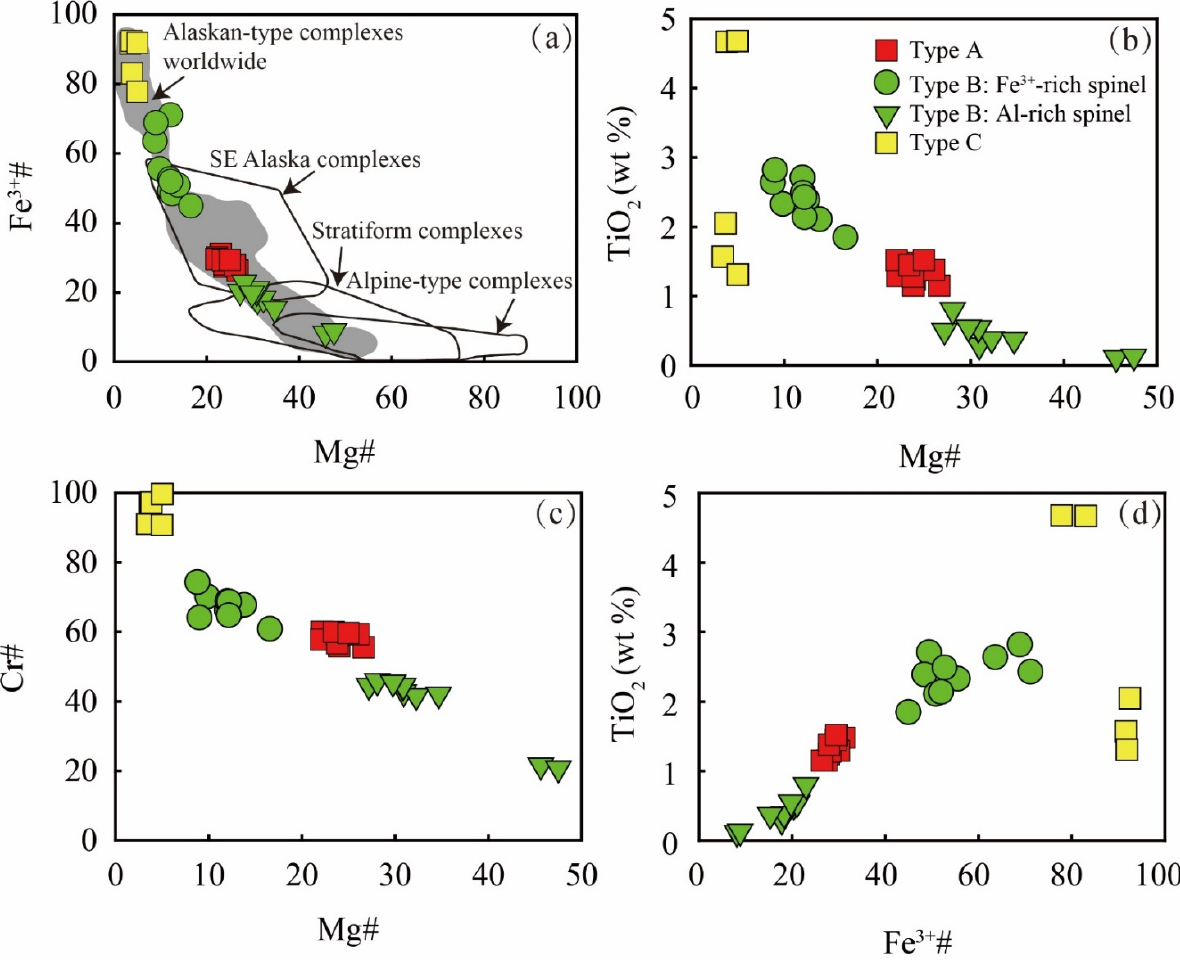
Figure 9. Correlation diagrams of ( a ) Mg# vs. Fe 3+ #, ( b ) Mg# vs. TiO 2 , ( c ) Mg# vs. Cr#, and ( d ) Fe 3+ # vs. TiO 2 for spinel in the dunite and wehrlite from the Duke Island complex. Fields of Alpine-type complexes, stratiform complexes, southeastern (SE) Alaska complexes, and Alaskan-type complexes worldwide are from [2,47].